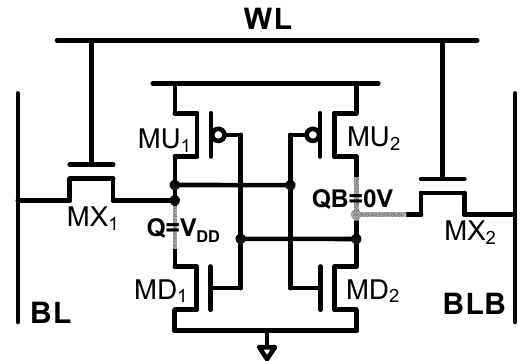
Figure 1. Schematic of the conventional 6 T SRAM cell.